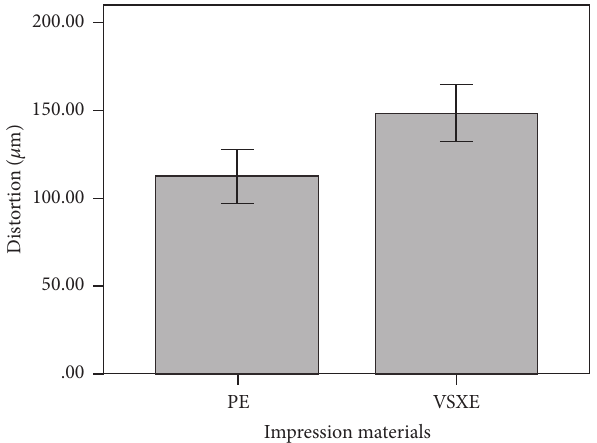
Figure 5: Descriptive mean analysis of test impression materials ( 𝜇 m).